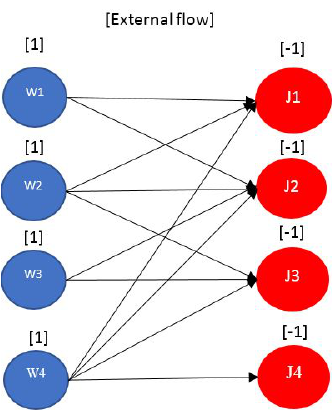
Figure 5. NFP model of the assignment